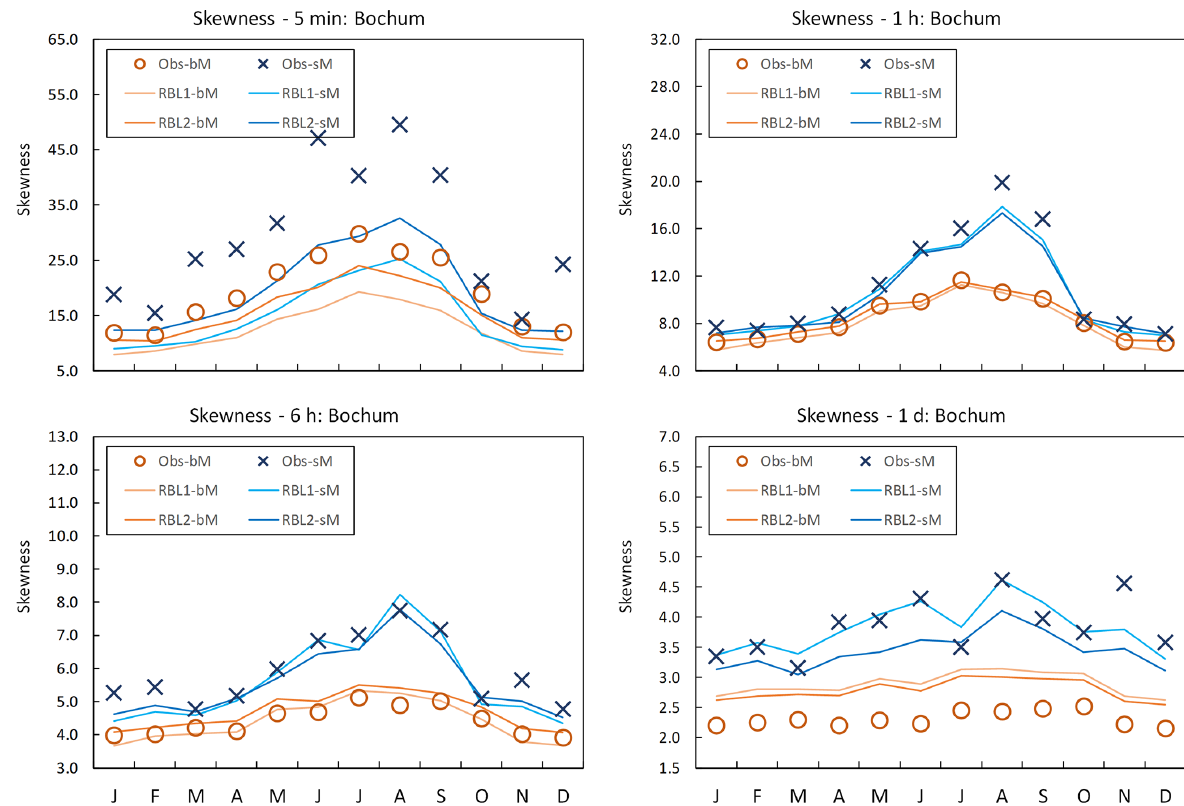
Figure 3. Coefficient of skewness by month at Bochum: the observed coefficient of skewness calculated with block (Obs-bM, orange circle markers) vs. standard (Obs-sM, blue cross markers) methods, the same with the RBL1 (RBL1-bM, light orange line; RBL1-sM, light blue line) models and the same with RBL2 (RBL2-bM, orange lines; RBL2-sM, blue lines)